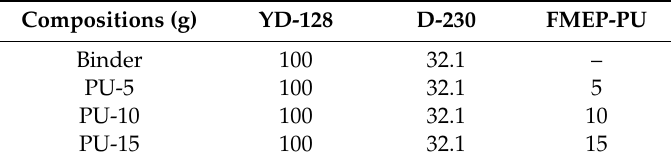
Table 1. Formulation information for the epoxy